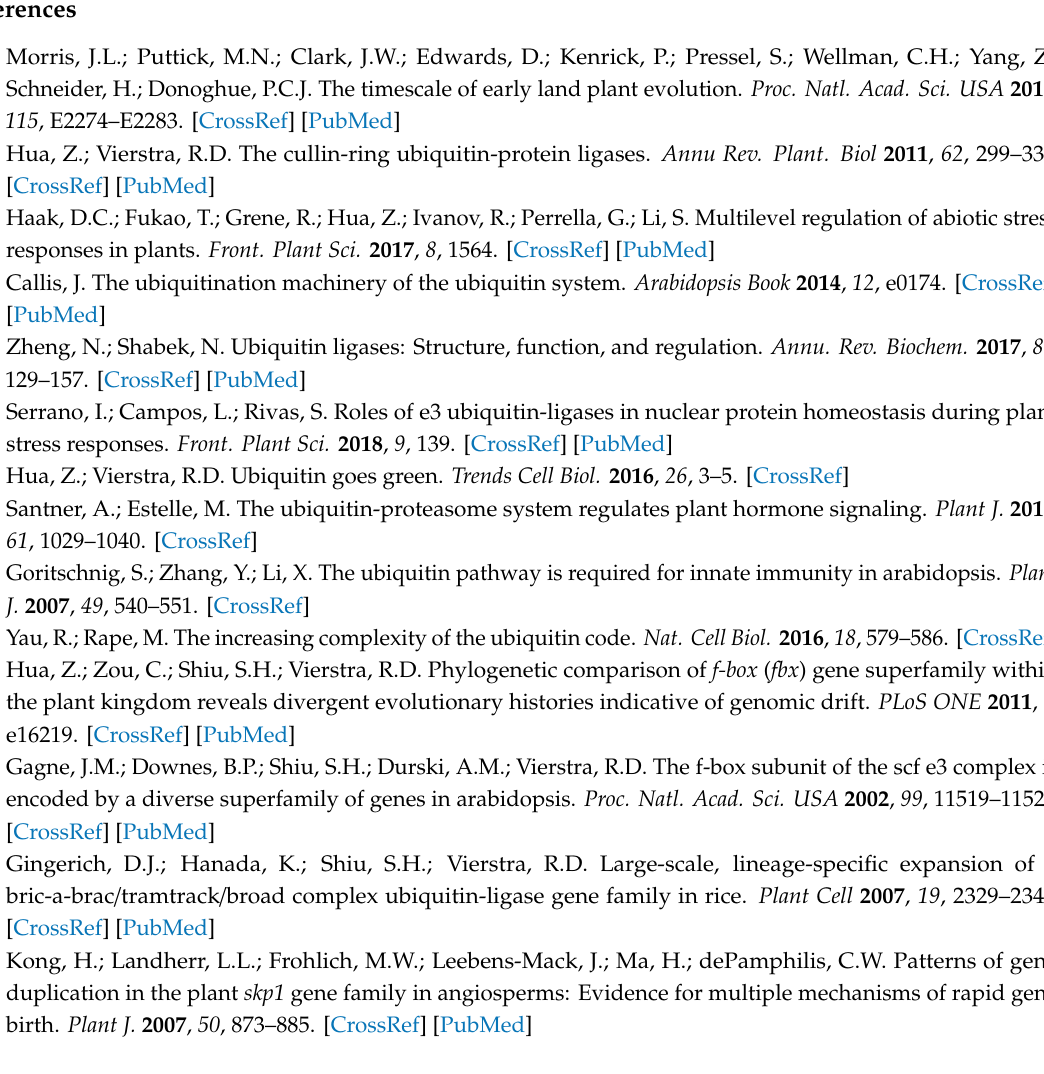
Figure S1 . Schematic representation of the UPS-mediated protein degradation and structural diagrams of 11 UPS families analyzed in this work. Figure S2 . Evolutionary selection analysis on age-ranked Skp1, Cullin, HECT, APC, E1, CP, and RP members from Aly – Ath and Osa – Obr orthologous pairs, respectively. Figure S3 . Phylogenetic relationships of the RP members from Aly , Aha , Ath , Osa , Obr , Opu , and Atr genomes. Species abbreviations are described in Table S2. Figure S4 . Phylogenetic relationships of the CP members from Aly , Aha , Ath , Osa , Obr , Opu , and Atr genomes. Species abbreviations are described in Table S2. Table S1 . List of seed files from Pfam. Table S2 . Data resources of 14 genomes analyzed in this work. Table S3 . Size comparison of the UPS in 14 genomes. Table S4 . Number of protein sequences identified in 11 UPS families in 14 genomes. Table S5 . Correlation assay of K a / K s , K a , and K s values with age ranks. File S1 . Protein sequences of the UPS members annotated from 14 genomes. File S2 . Coding sequences of the UPS members annotated from 14